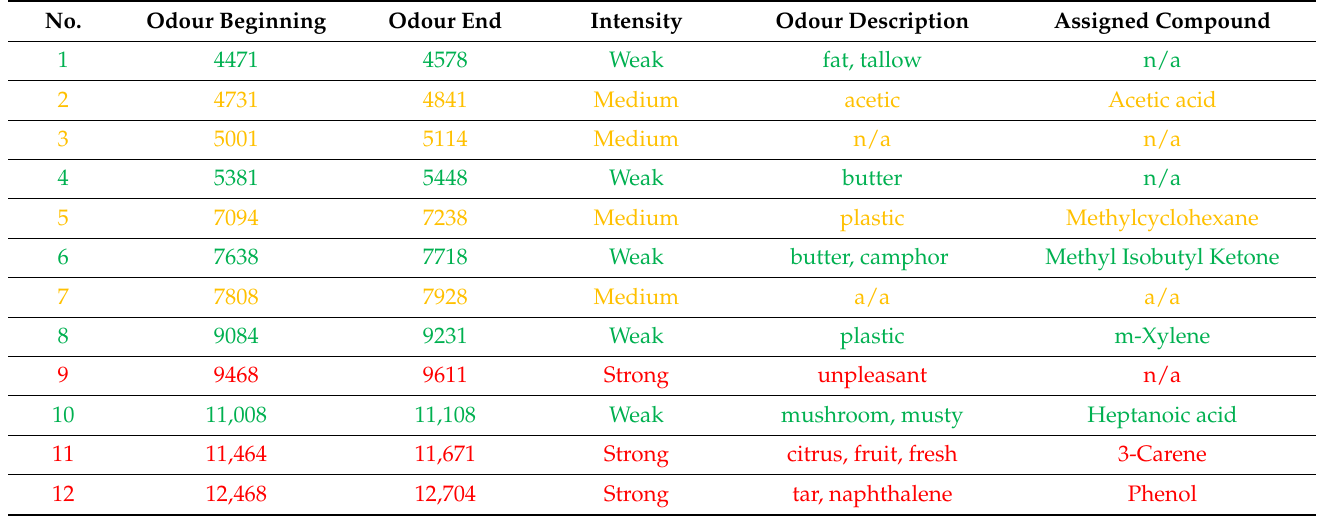
Figure 7. Chromatographic spectrum with the applied odour signals obtained for the air sample collected from the emission chamber after three days. Table 3. Identification of the signals obtained for the air sample collected from the emission cham- ber.